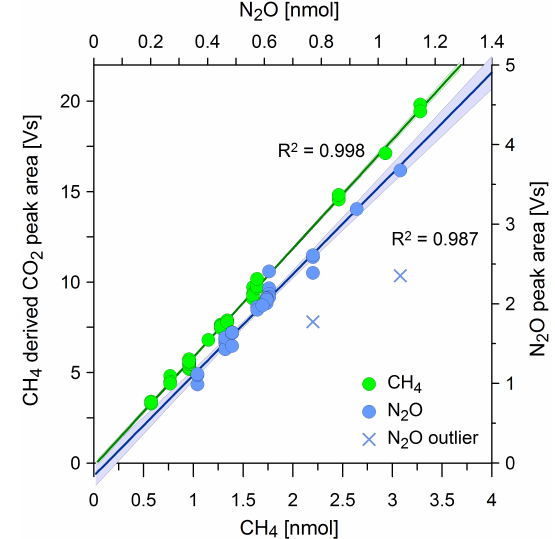
Fig. 5. Sample recovery. Green circles show the injected CH 4 amount [nmol] and the resulting IRMS peak area [Vs] as detected during bubble-free ice measurements with the injection of four dif- ferent air mixtures in variable amounts. Blue circles display ana- logue information for N 2 O. The two blue crosses show outliers of N 2 O that suffered from a loss of IRMS peak area for unknown rea- sons. Both outliers are therefore not included in the calculation of the regression, which are shown with 95% confidence